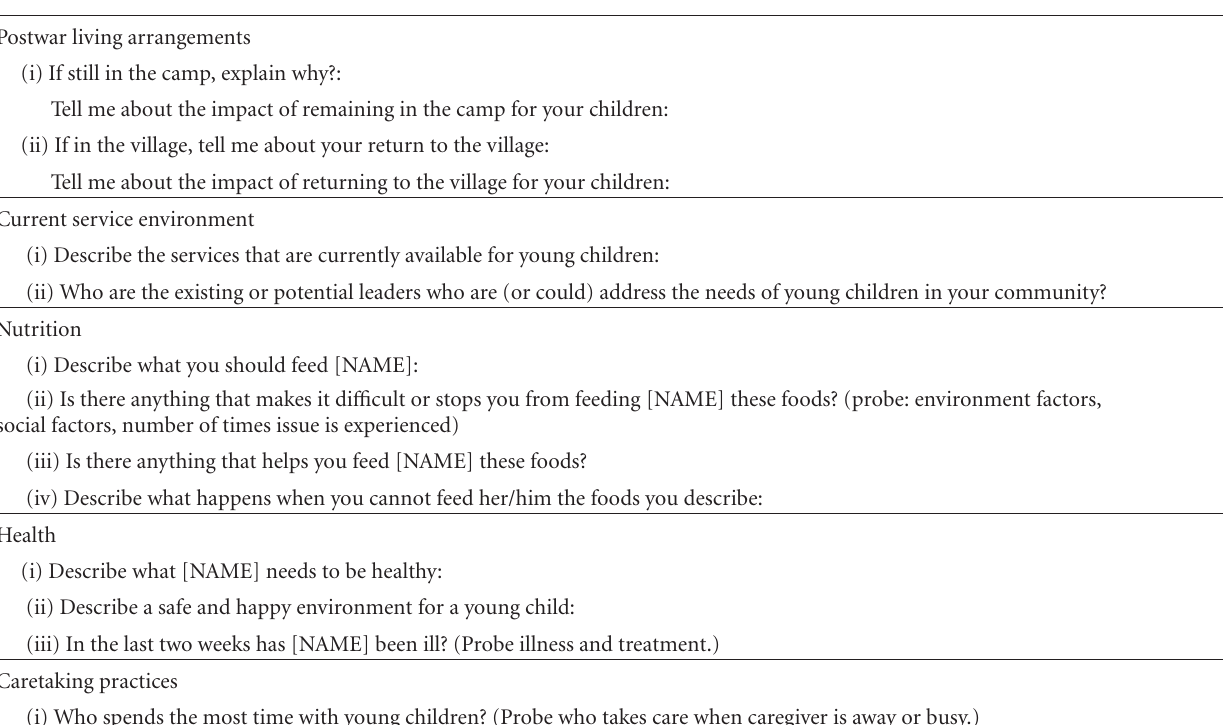
Table 3: Examples of questions guiding interviews and focus